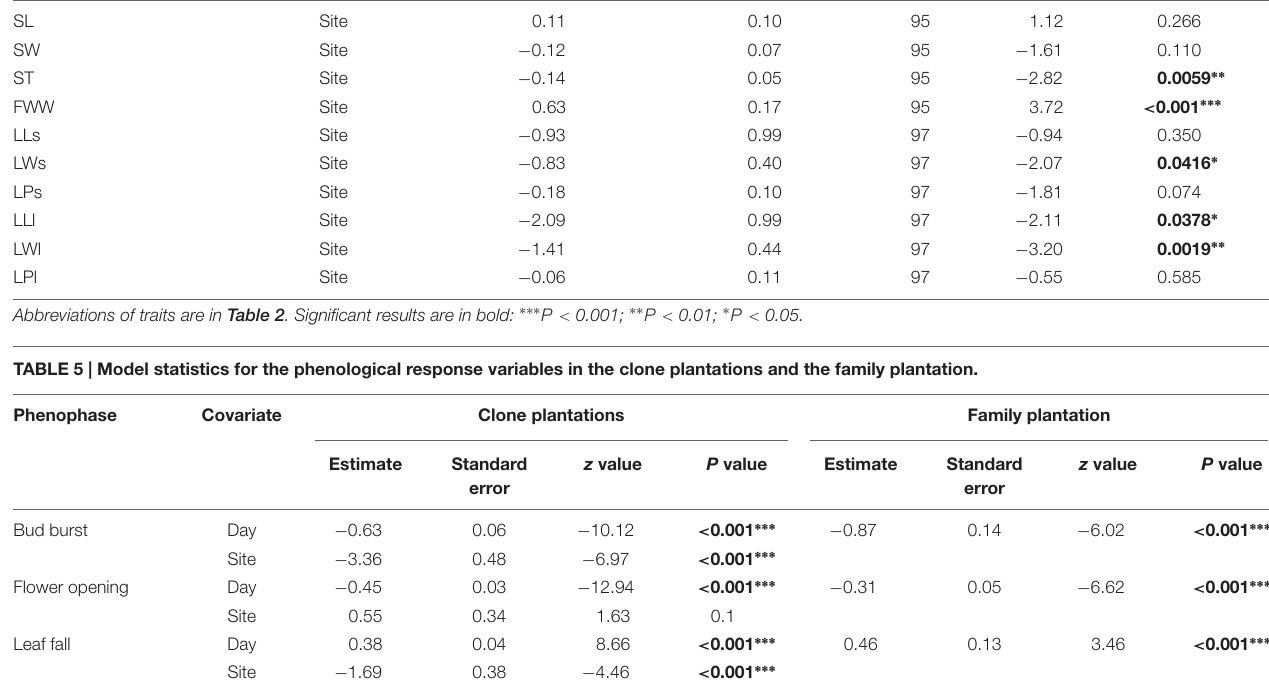
TABLE 4 | Model statistics for the covariate site (clone plantations) in the mixed models with the individual morphological traits as response variables. Response variable